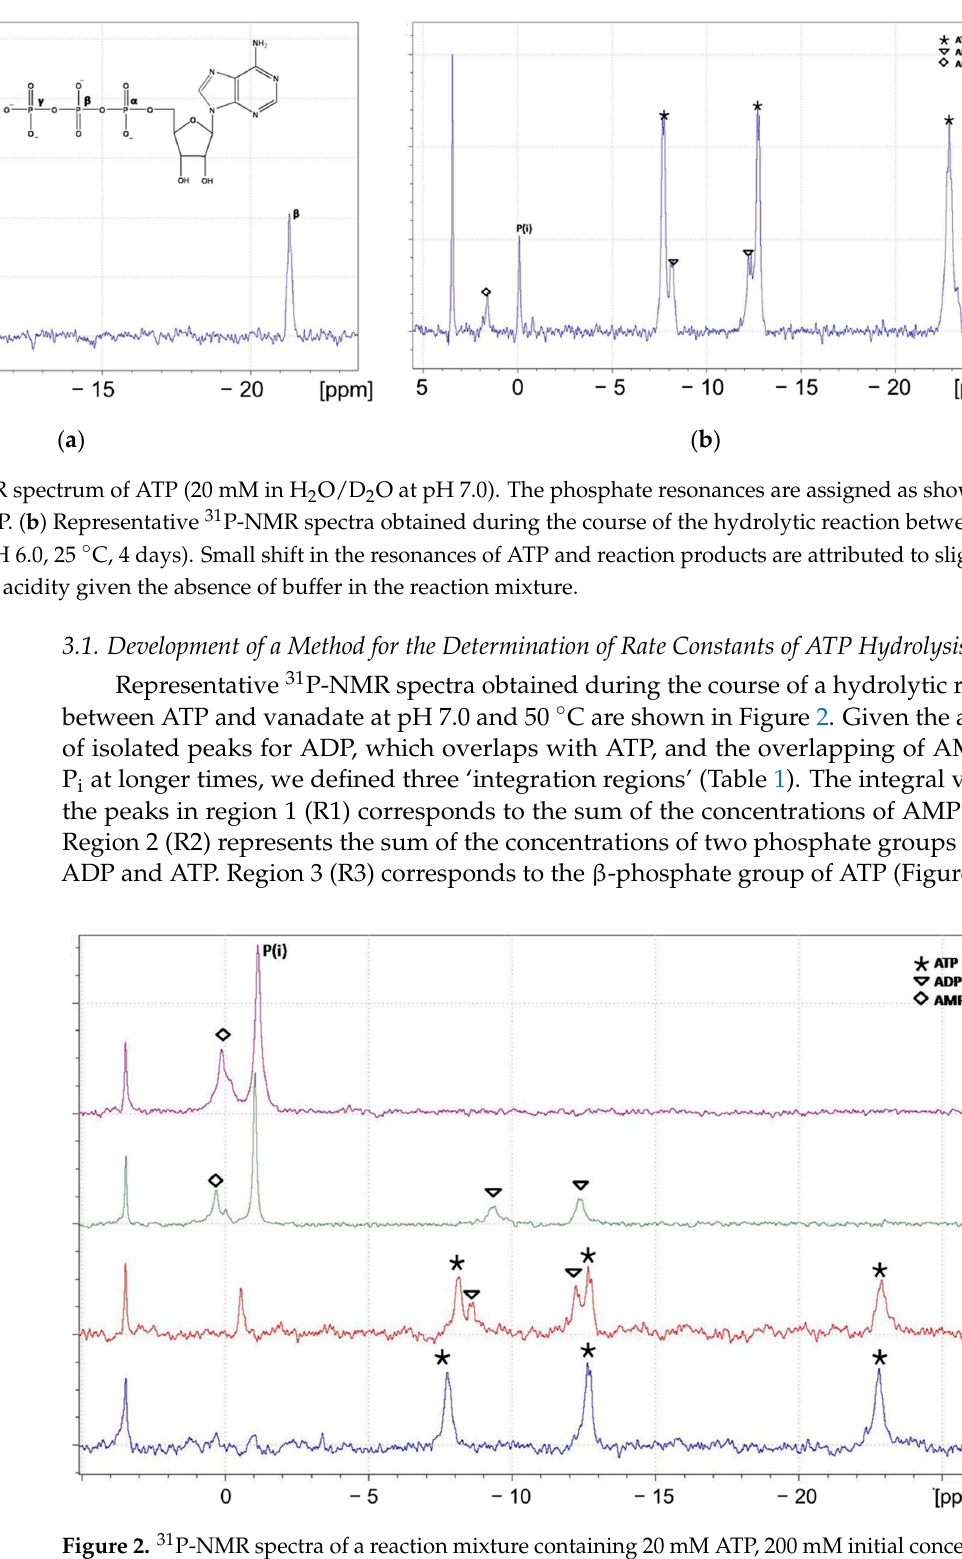
Figure 2. 31 P-NMR spectra of a reaction mixture containing 20 mM ATP, 200 mM initial